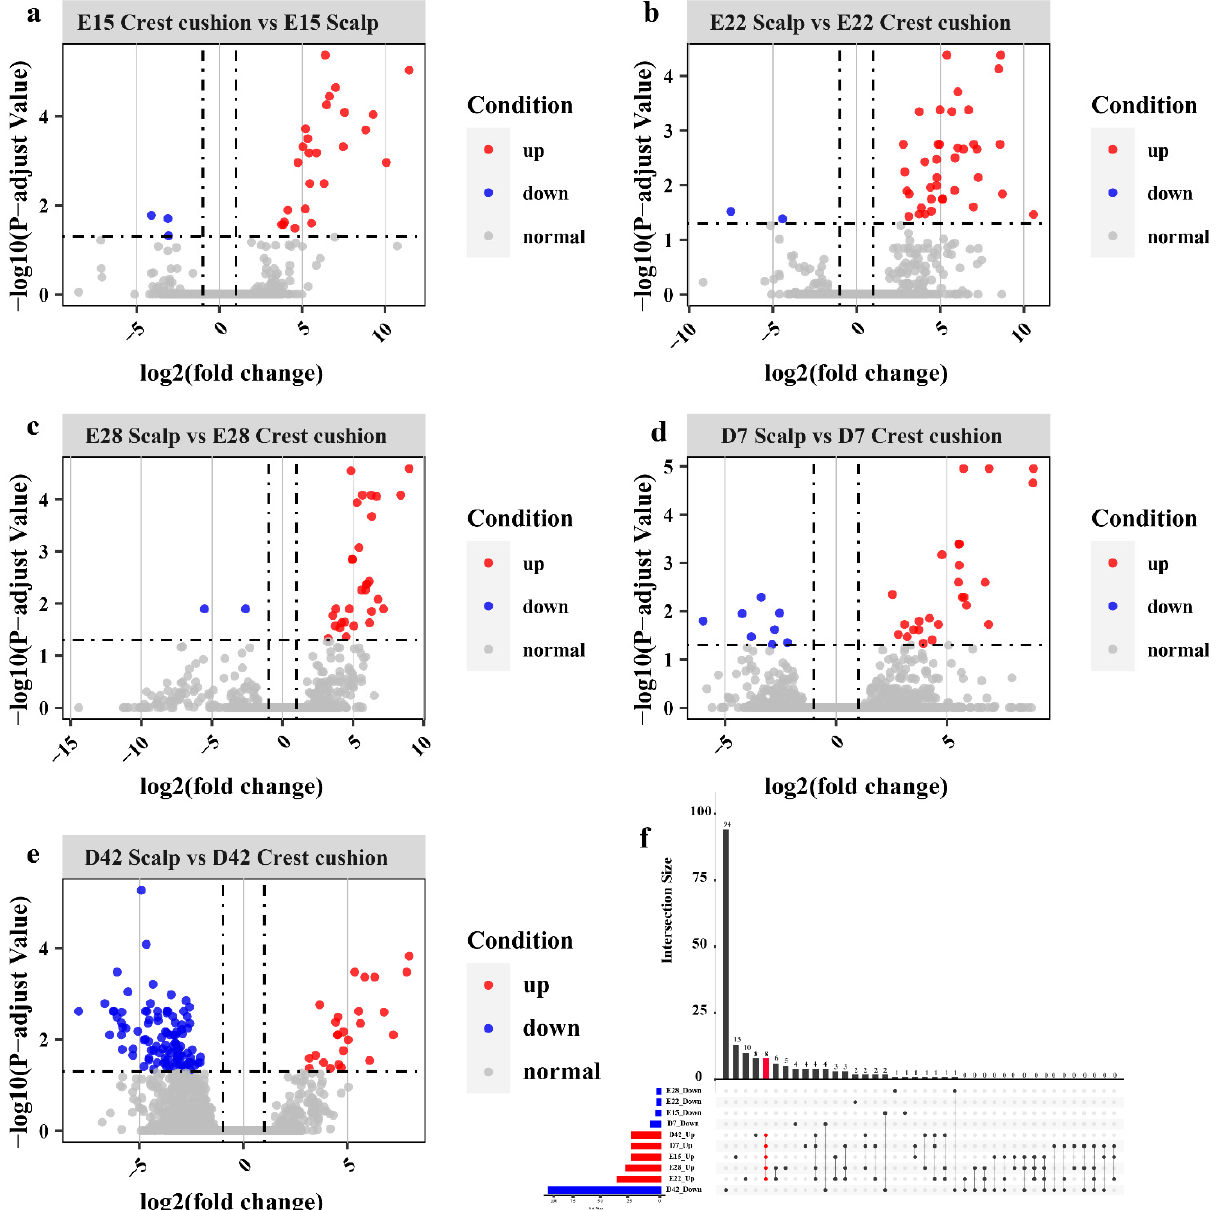
Figure 2. Volcano plots of the distribution trends of differentially expressed genes in crest cushion and scalp tissue at different developmental stages. ( a ) E15 stage; ( b ) E22 stage; ( c ) E28 stage; ( d ) D7 stage; ( e ) D42 stage; ( f ) Upset plot of all comparison groups.